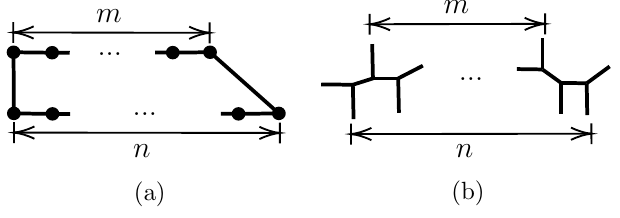
Figure 4 . The toric diagram for the generalized conifold and its dual